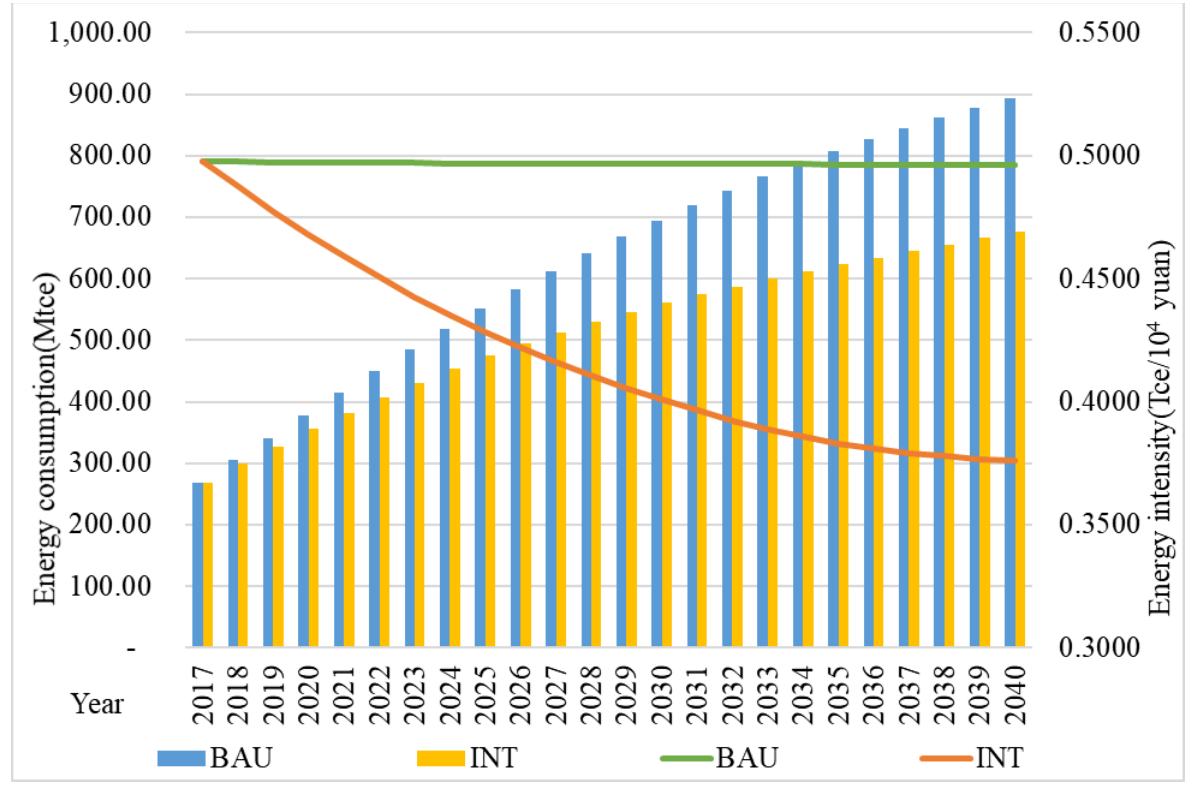
Figure 2. Forecast of total energy consumption and energy intensity under two scenarios.